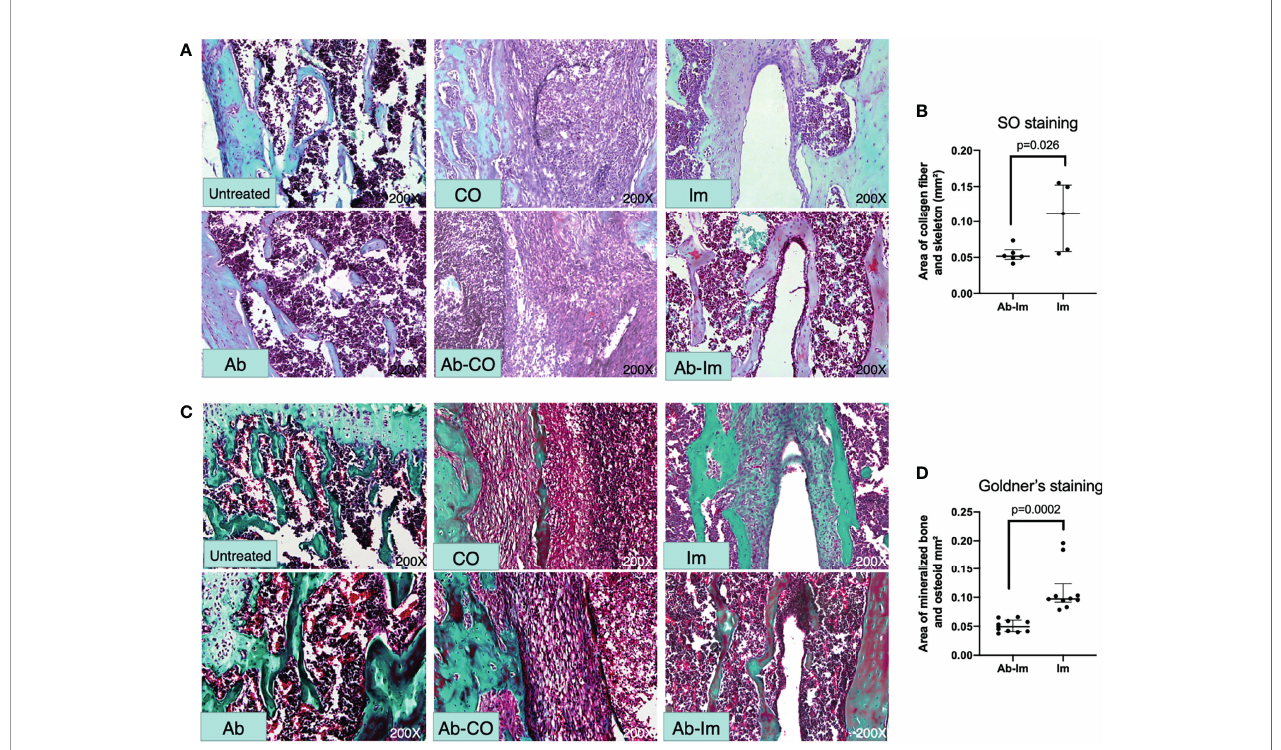
FIGURE 3 | Antibiotic-induced gut microbiota dysregulation interfered with osteoblastogenesis. Distal femur specimens were harvested and stained with Safranin O-fast green (200× magni fi cation) and Goldner ’ s trichrome (200× magni fi cation) at 4 weeks postsurgery. (A) In the Safranin O staining images, deep red indicates cartilage matrix; blue indicates the chondrocyte nuclei; gray-green indicates the cytoplasm, muscle, collagen fi ber, and skeleton; red indicates the chondrocyte cytoplasm; and gray-black indicates the cell nuclei. (B) Area of collagen fi ber and skeleton around intramedullary nail based on Safranin O-fast green staining results from mice in the Im and Ab-Im groups (n=5). (C) In the Goldner ’ s staining images, green indicates mineralized bone; orange-red indicates osteoid tissue; purple indicates cartilage; and blue-gray indicates cell nuclei. (D) Area of mineralized bone and osteoid around intramedullary nail based on Goldner ’ s trichrome staining results from mice in the implant and Ab-implant groups (n=10). Abscess formation and sequestra can be seen in the CO and Ab-CO groups. Mature mineralized bone was evident in the nail path of the Im group but not in the Ab-Im group. Data are shown as the median and interquartile range, and analyzed by unpaired t